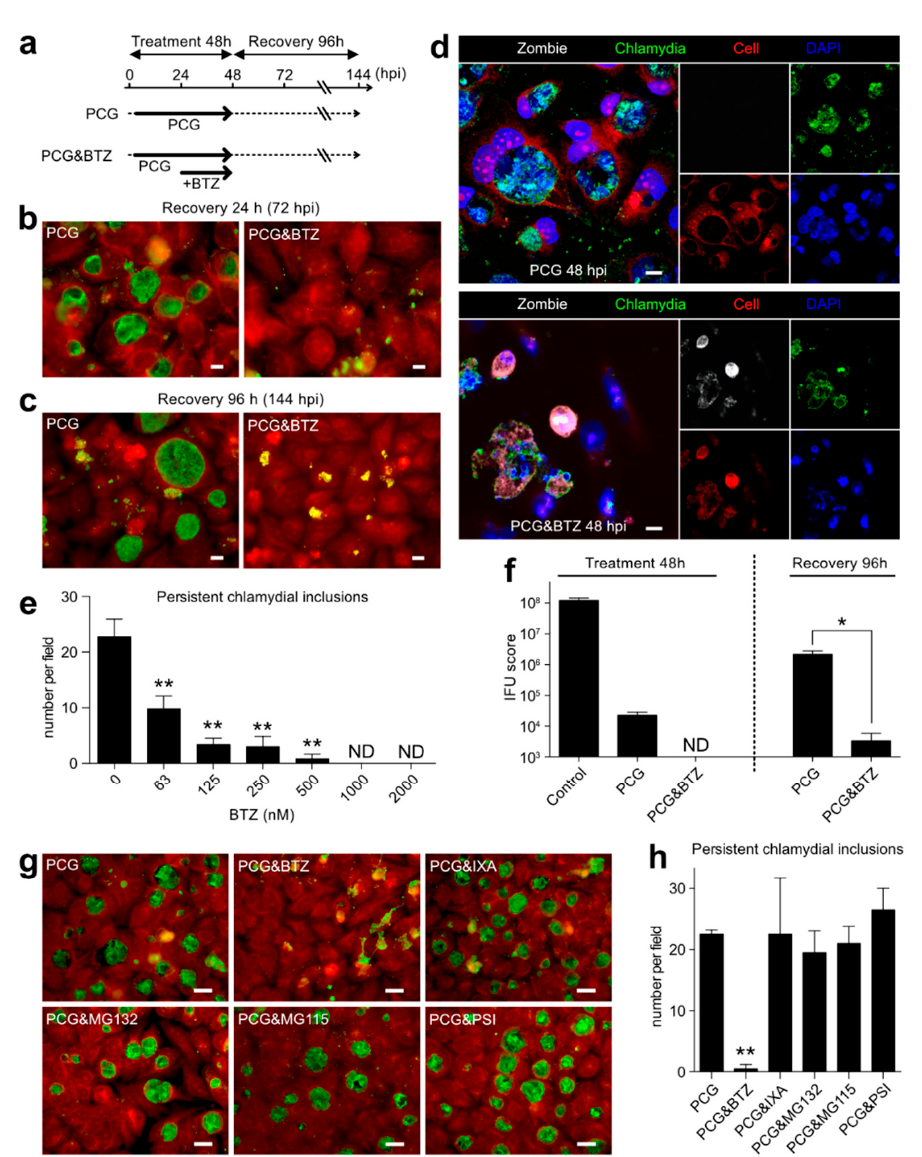
Figure 5. BTZ specifically kills host cells harboring persistently infected Chlamydia . ( a ) Schematic diagram of C. trachomatis L2 infection and time course of the chemical treatment. ( b , c ) The infected cells were treated with PCG or 1 µ M BTZ, fixed at 48 hpi ( b ) or 144 hpi ( c ), and stained as described in Figure 1. Scale bar, 20 µ m. ( d ) Representative fluorescence images of persistently Chlamydia -infected cells living (top) or causing apoptosis by PCG and BTZ treatment (bottom). Scale bar, 10 µ m. ( e ) At 72 hpi (recovery 24 h), the cells were fixed, stained, and counted as the live persistently infected chlamydial inclusion per field under a microscope ( × 40). Data are the mean ± SD of the number of live chlamydial inclusion in five fields. ( f ) The infected cells were treated with indicated chemicals and harvested at 48 hpi (treatment 48 h) or 144 hpi (recovery 96 h), and the IFU scores were evaluated. Data are the mean ± SD of three independent wells. ( g ) The infected cells were treated with PCG for 24 h and then separately added with the indicated chemicals (1 µ M each) for a further 24 h. Cells were fixed and stained at 48 hpi. A red stain denotes Evans blue counterstaining. Scale bar, 10 µ m. ( h ) The live persistently infected chlamydial inclusions were counted under a microscope. Data are the mean ± SD of number of live chlamydial inclusion in three fields. * p < 0.05 and ** p < 0.01 compared to each control sample by Welch’s t -tests. ND, not